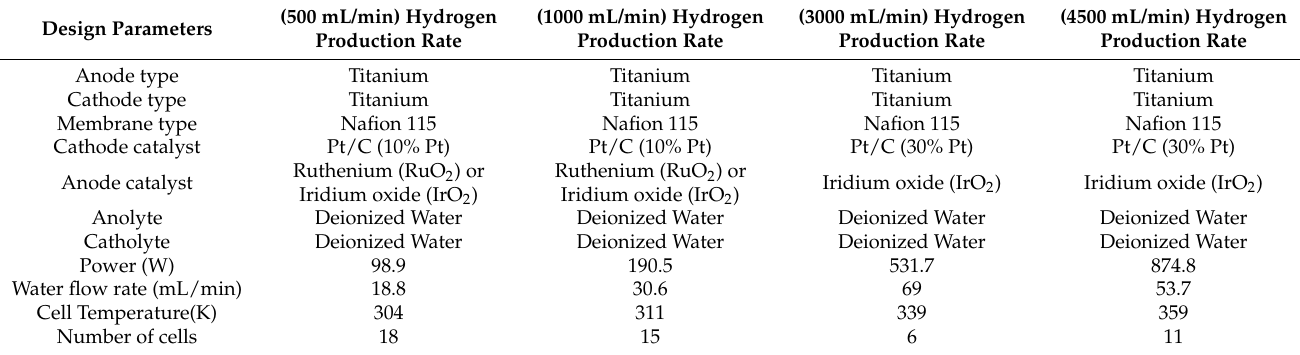
Table 4. Optimal predicted parameters for suggested commercial-sized PEM cell